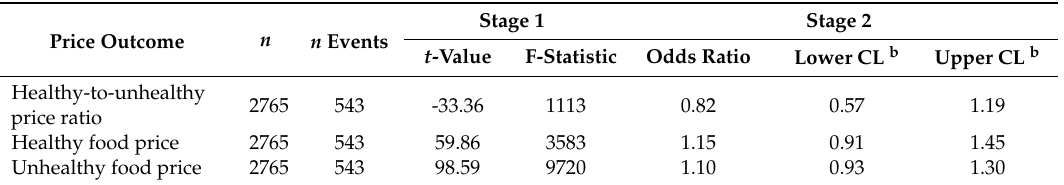
Table 5. Instrumental variable analysis results using toilet paper as the instrument and two-stage residual inclusion models for the healthy-to-unhealthy price ratio, healthy food price, and unhealthy food price ( n = 2765) a